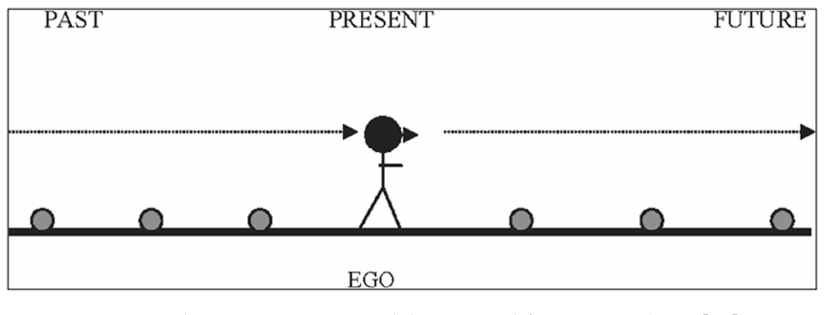
Figure 5. The Moving Time Model; reprinted from Evans (2007 [20]).